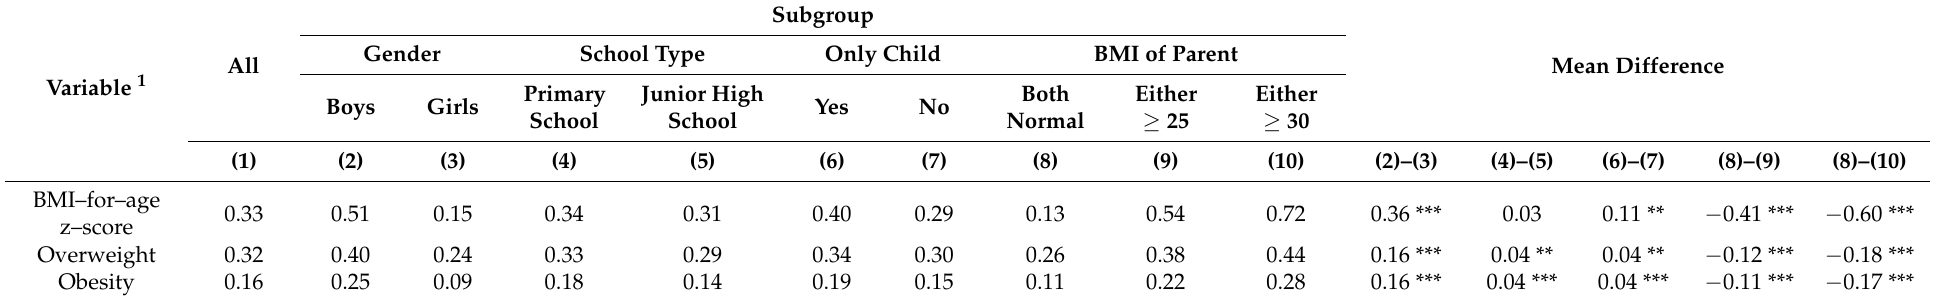
Table 3. BMI–for–age z–score distribution of students by personal/family characteristics in full sample and subgroups.